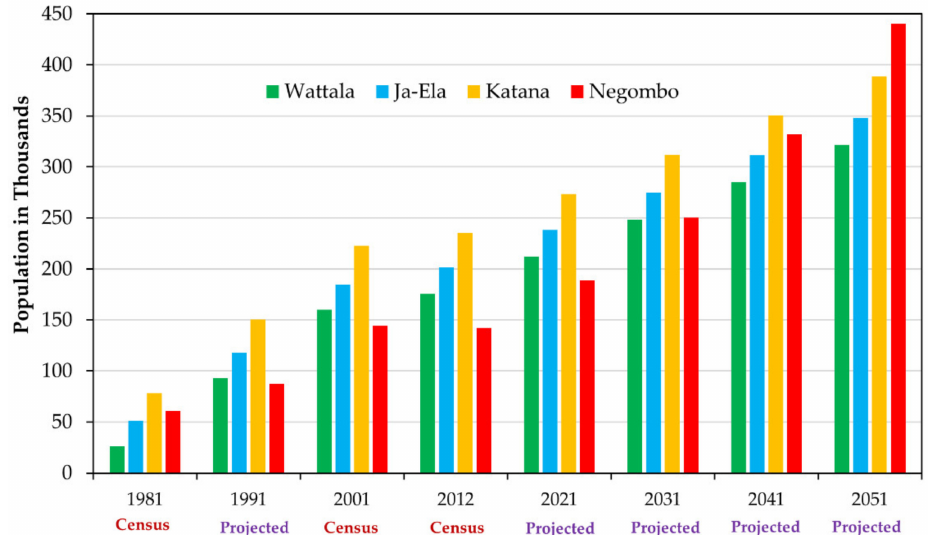
Figure 8. Projected population trend for Wattala, Ja-Ela, Katana and Negombo DSDs of Gampaha District: The population data for 1981, 2001 and 2012 were sourced from the Department of Census and Statistics, Sri Lanka [85]. The 1991 population was projected using growth rates of 5.1%, 2.6%, 2.1%, and 6.9% for Wattala, Ja-Ela, Katana, and Negombo, respectively. From 2021 to 2051, growth rates were projected using rates of 0.87%, 0.83%, 0.51%, and − 0.13% for Wattala, Ja-Ela, Katana, and Negombo,